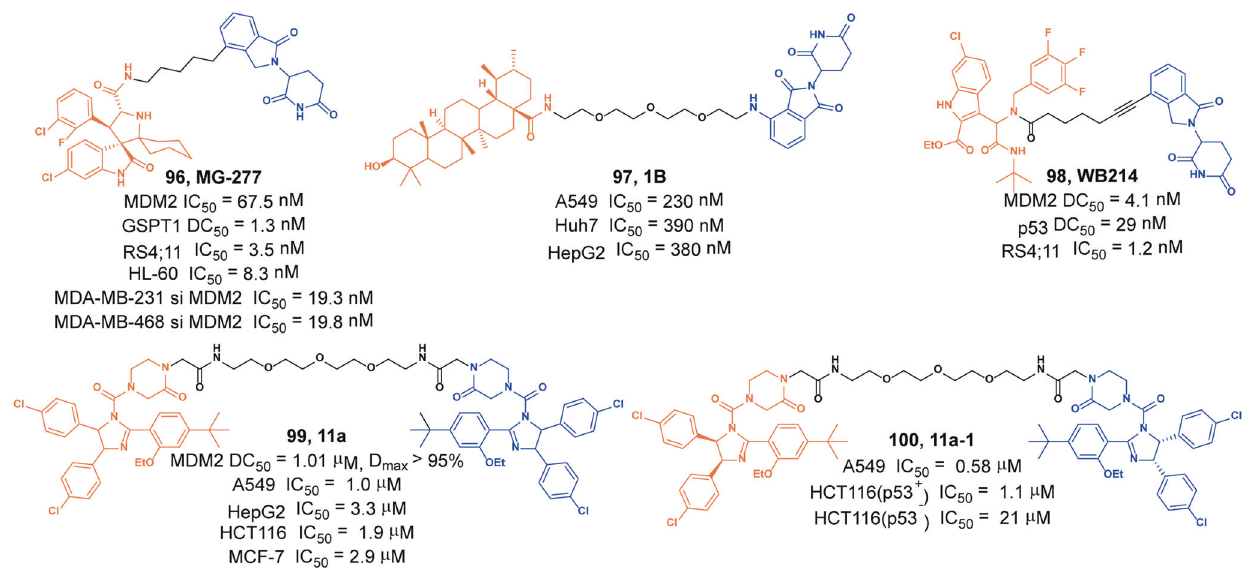
Fig. 23 The representative PROTACs targeting